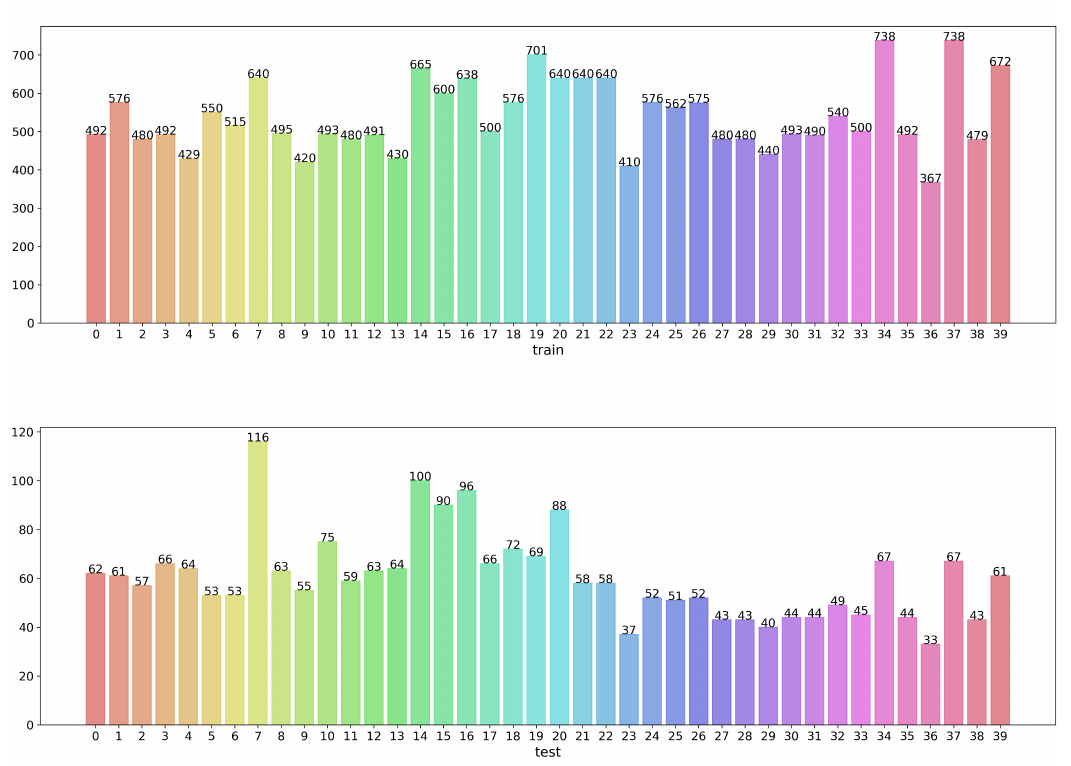
Figure 9. Data distribution for the Indian fruits dataset. These data are already split by the original publishers of the dataset by the ratio of 9 to 1. Labels are assigned in alphabetical